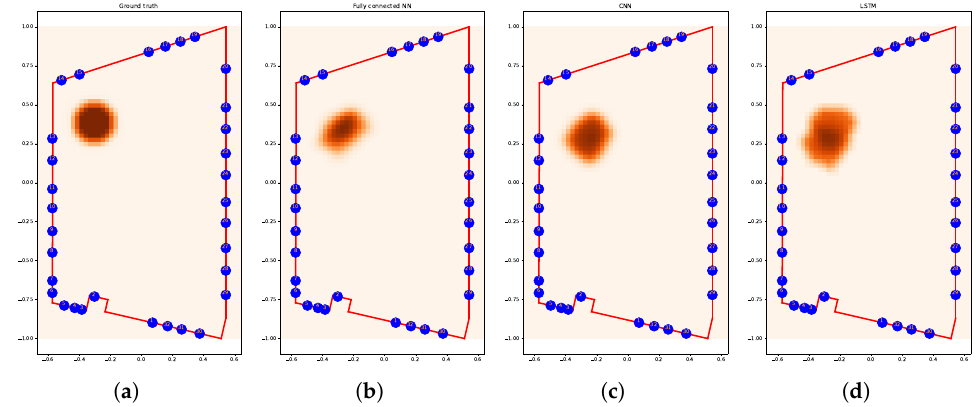
Figure 15. Reconstructions from the second test measurement. ( a ) Ground truth. ( b ) Fully connected NN. ( c ) CNN. ( d ) LSTM.